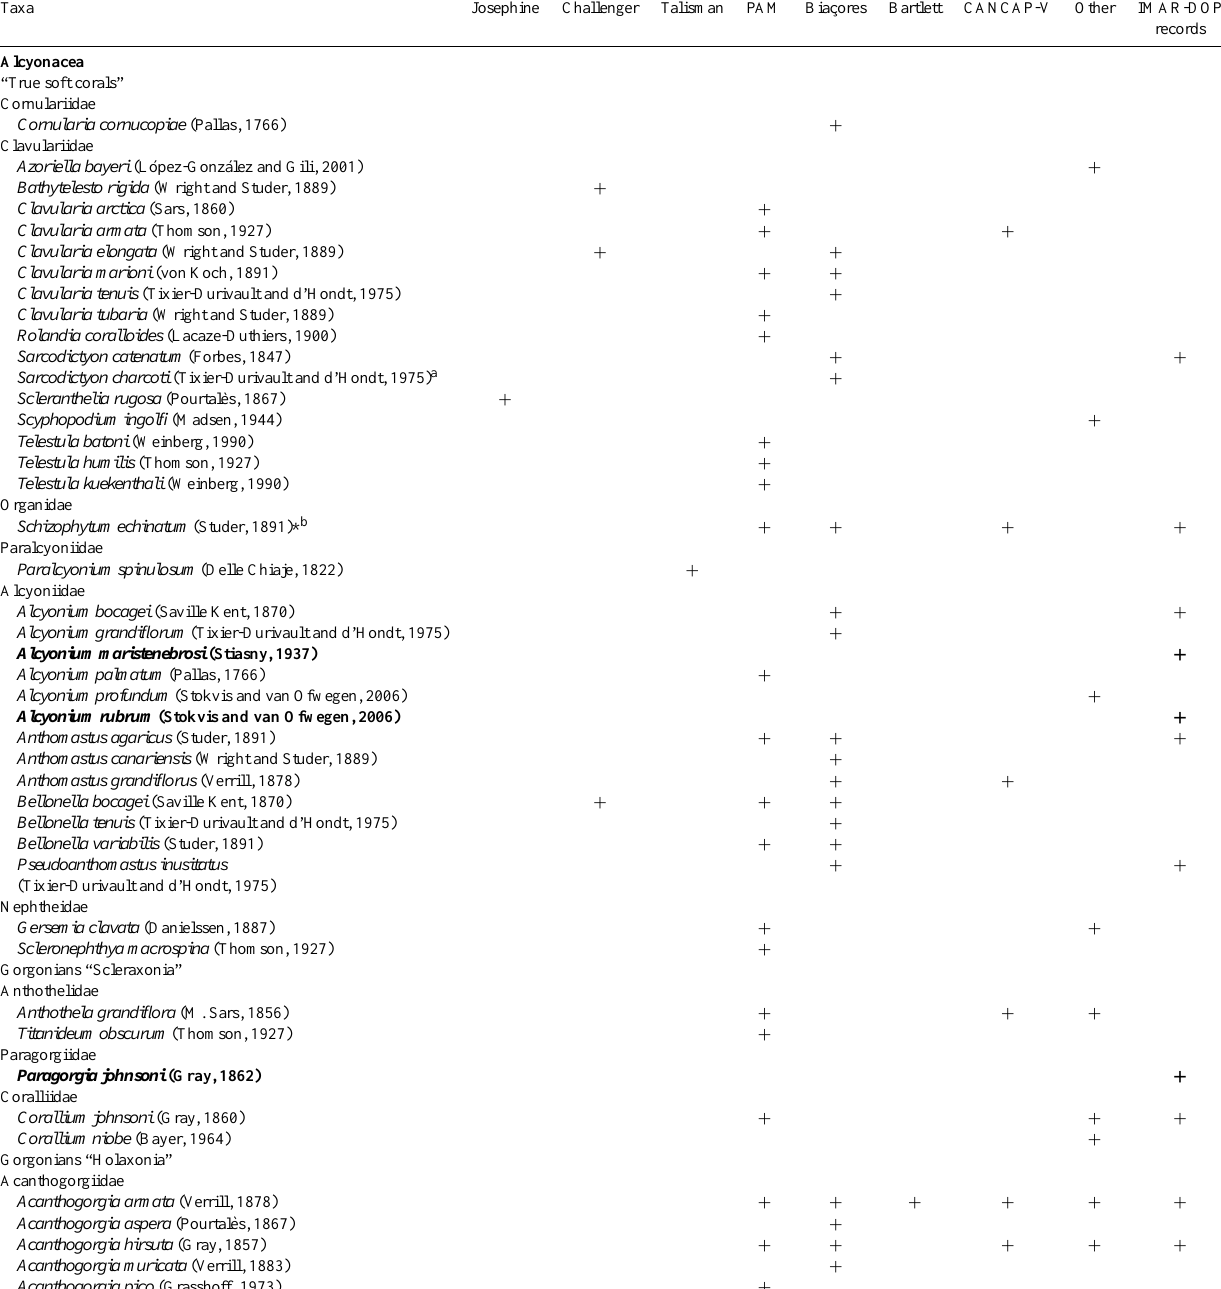
Table A1. List of species of Alcyonacea, Antipatharia, Scleractinia and Stylasteridae identified in the Azores EEZ according to major oceanographic campaigns, other sources and IMAR-DOP/UAc records. Records from the CANCAP-V available online at the collection database of the Smithsonian National Museum of Natural History are indicated with an asterisk. See Table 1 for data source details. Signs in boldface indicate first species